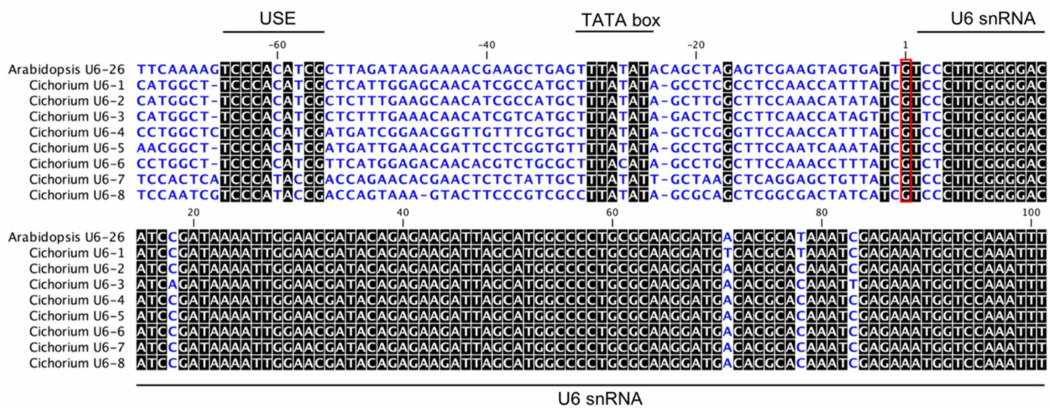
Figure 1. Chicory U6 and Arabidopsis U6-26 gene sequence partial alignment. The highly conserved parts of the sequences are in black while the Upstream Sequence Elements (USE), the TATA-boxes and the U6 small nuclear (snRNA) genes are marked with black bars. The transcription start sites are indicated (red